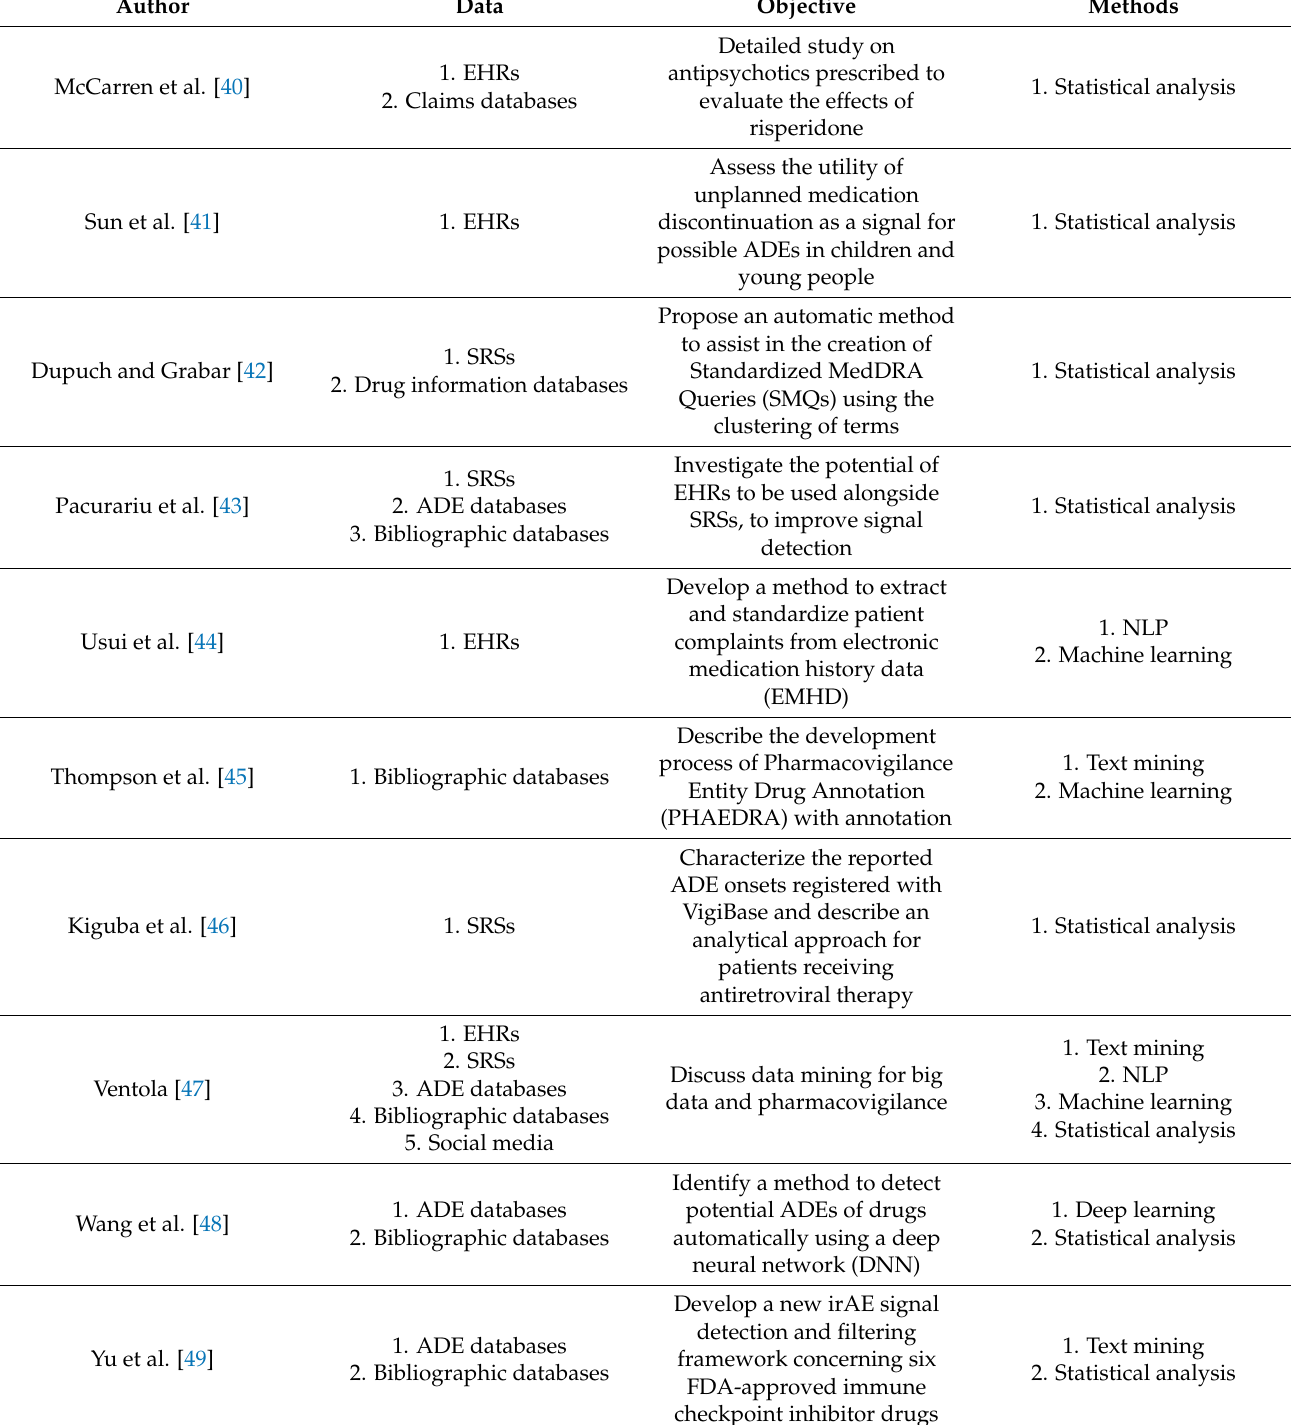
Table 3. List of papers for ADR detection methods and